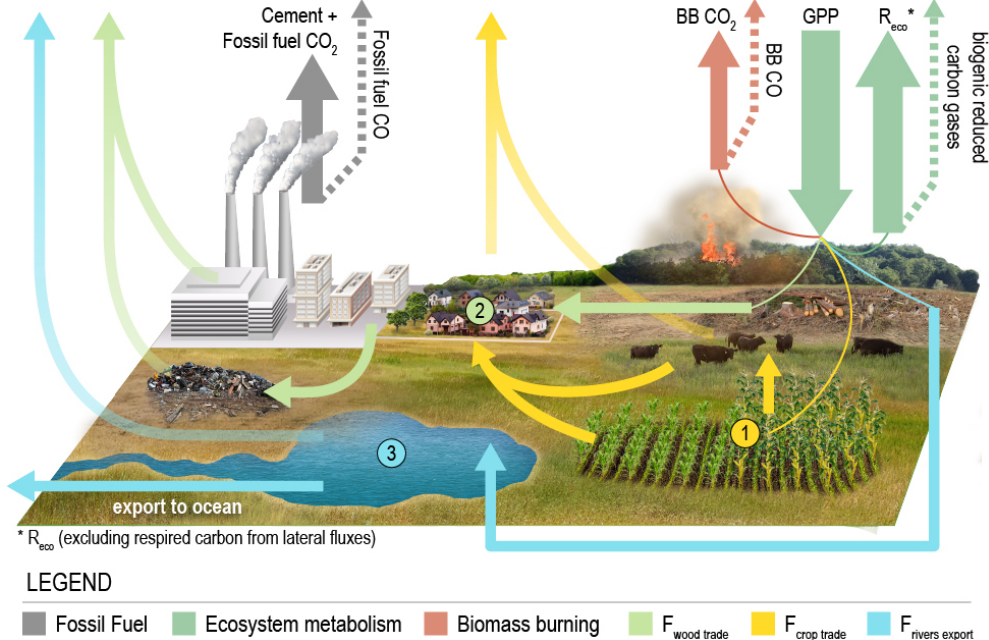
Figure 1. CO 2 is removed from the atmosphere through photosynthesis (GPP) and then emitted back to the atmosphere through a number of processes. Three processes move carbon laterally on Earth’s surface such that emissions of CO 2 occur in a different region than removals. (1) Agriculture: harvested crops are transported to urban areas and to livestock, which are themselves exported to urban areas. CO 2 is respired to the atmosphere in livestock or urban areas. (2) Forestry: logged carbon is transported to urban and industrial areas, then emitted through decomposition in a landfill or combustion as a biofuel. (3) Water cycle: carbon is leached from soils into water bodies, such as lakes. The carbon is then either deposited, released to the atmosphere or transported to the ocean (Regnier et al., 2022). Arrows show carbon fluxes, and colors indicate whether the flux is associated with (grey) fossil fuel emissions, (dark green) ecosystem metabolism, (red) biomass burning, (light green) forestry, (yellow) agriculture or (blue) the water cycle. Semi-transparent arrows show fluxes that move between the surface and atmosphere, while solid arrows show fluxes that move between land regions. Dashed arrows show surface–atmosphere fluxes of reduced carbon species that are oxidized to CO 2 in the atmosphere. For simplicity, a cement carbonation sink, volcano emissions and a weathering sink are not included in this